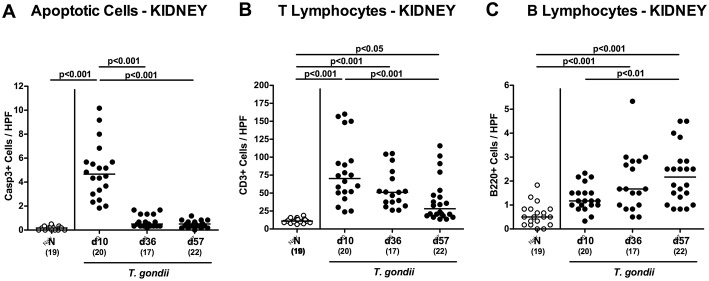
Microscopic inflammatory sequelae in the kidneys over time following peroral low-dose T. gondii infection. Mice were perorally infected with one cyst of T. gondii on day 0 and surveyed at days (d) 10, 36, and 57 post-infection (p.i.; closed circles). Naive (N) mice served as uninfected controls (open circles). Out of six representative high power fields (HPF, 400x magnification) per animal the average numbers of (A) apoptotic (casapse3+, Casp3+) cells, of (B) T lymphocytes (CD3+) and (C) B lymphocytes were assessed in immunohistochemically stained renal paraffin sections. Medians (black bars), levels of significance (p-values) as determined by one-way ANOVA test followed by Tukey post-correction for multiple comparisons and numbers of analyzed mice (in parentheses) are indicated. Data were pooled from four independent experiments.